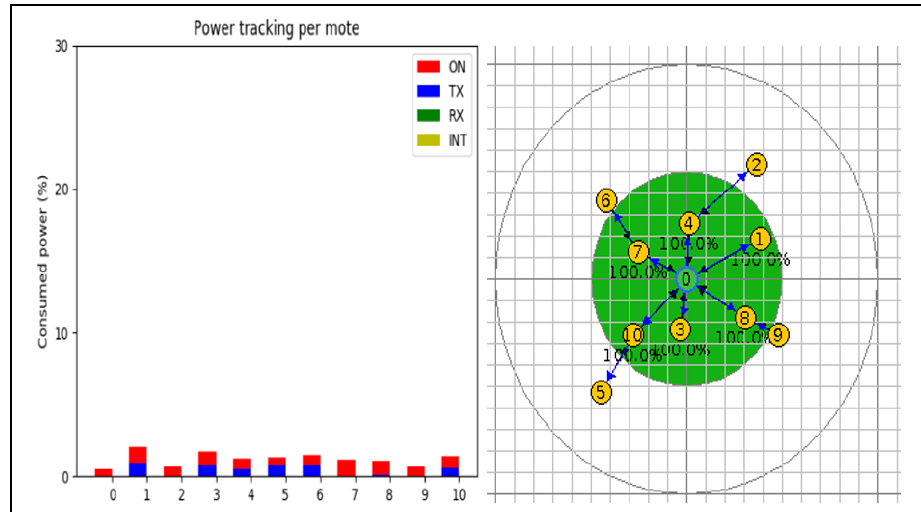
Figure 4. Cooja simulation network snap ( right ) and power usage ( Left ) in the sensors without malicious mote. Sink (green) and sources (yellow).